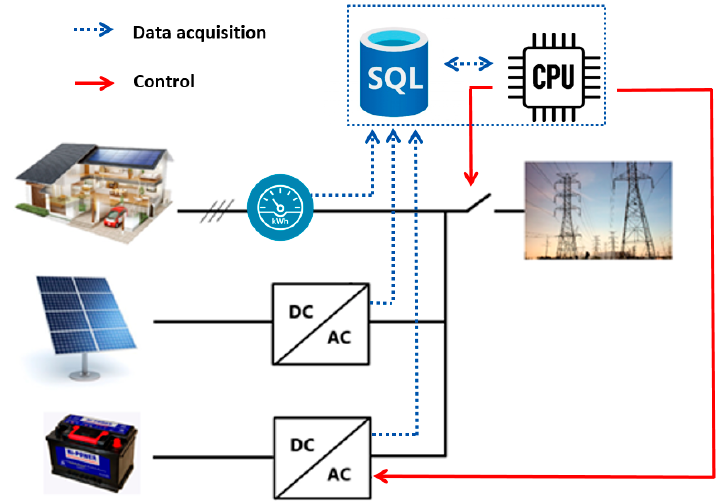
Figure 1. Power topology of AC-coupled ESS with the role of the energy manager.